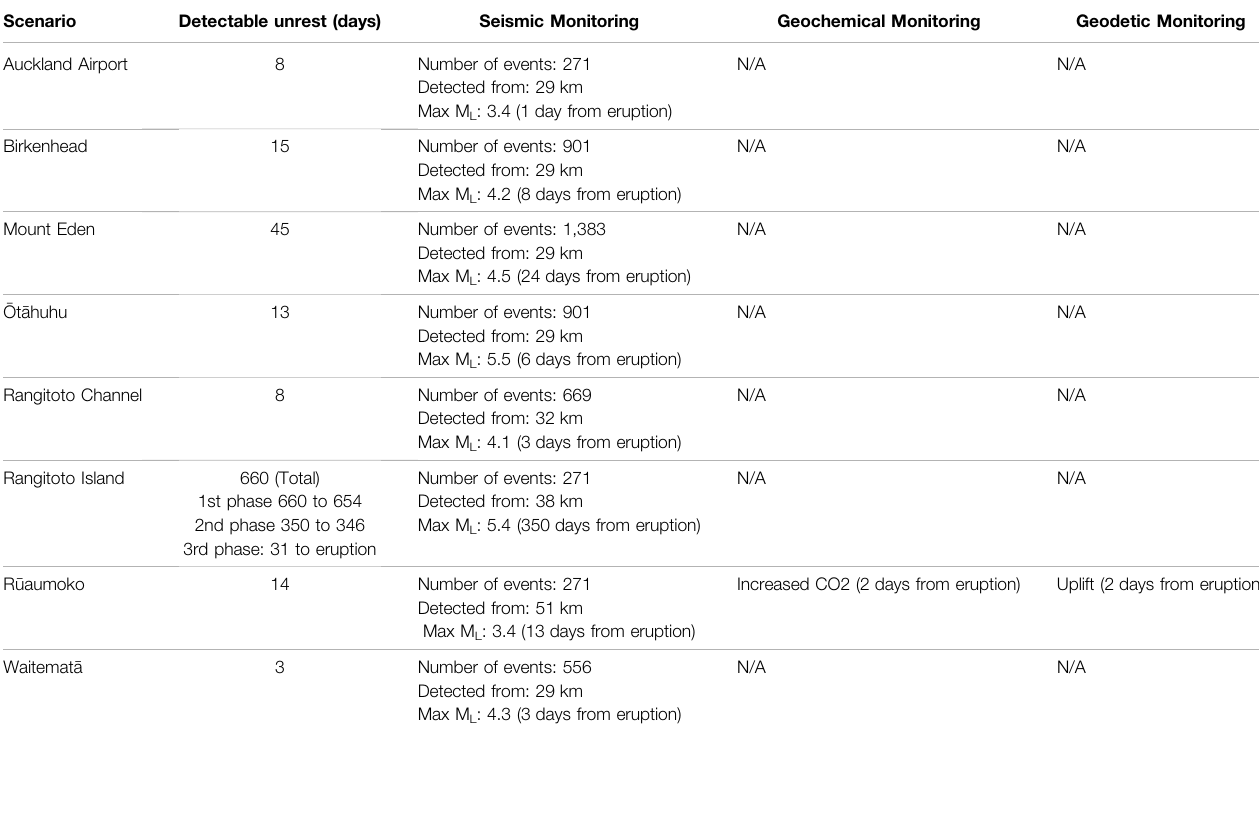
TABLE 2 | Overview of the eight AVF scenarios ’ pre-eruptive sequences. Refer to Hayes et al. (2018) for more information. Scenario Detectable unrest